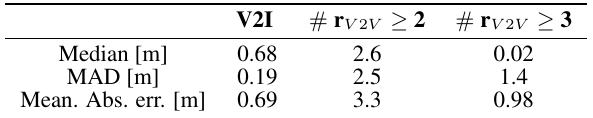
Table 3. Cooperative positioning: 2D